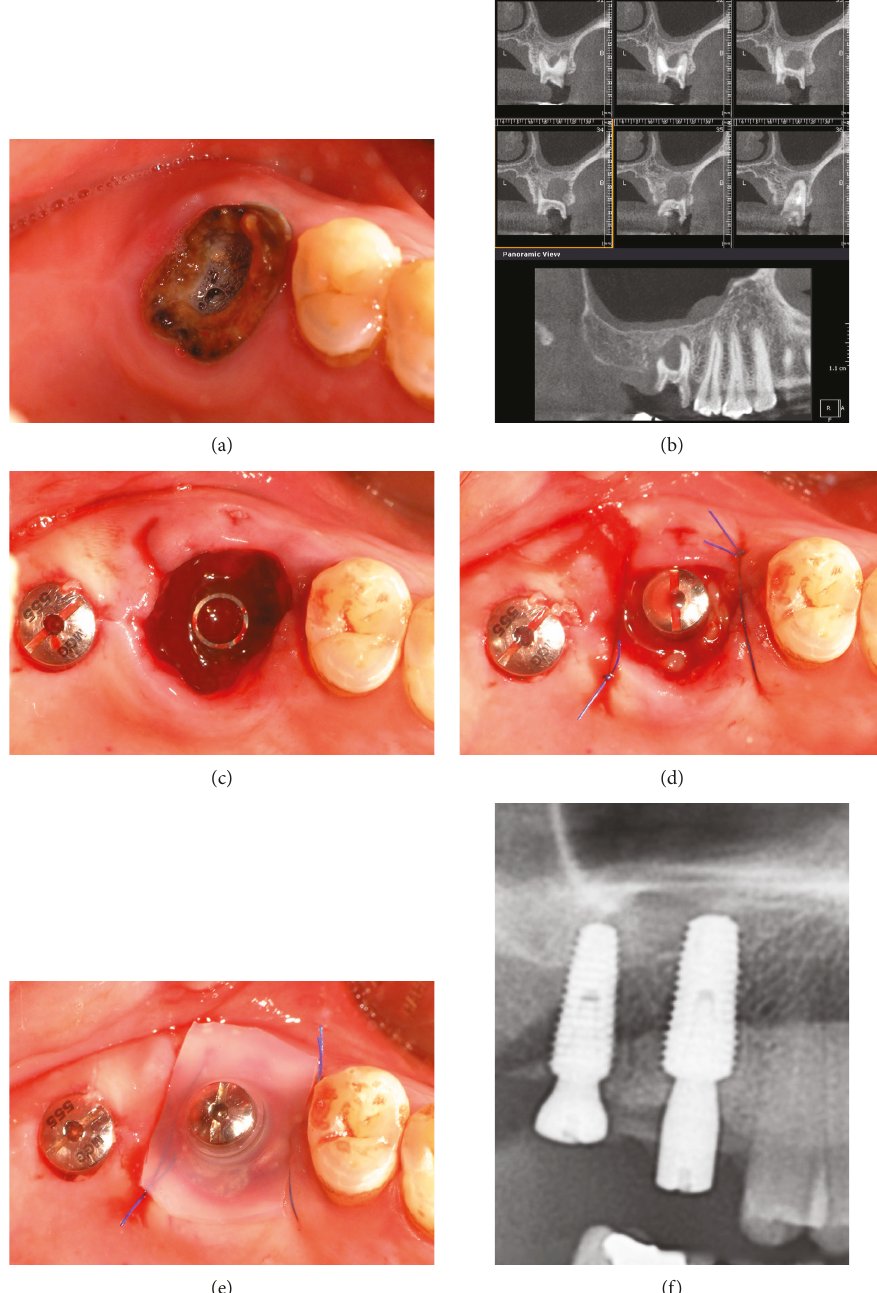
Figure 4: (a) Occlusal view at the initial examination. (b) Cone beam computerized tomography image at the initial examination. (c) Occlusal view immediately after the insertion of the implant. (d) Clinical condition of the interrupted sutures after gap fi lling of the extraction socket with allogenic bone and PRF. (e) Application of the silicone cap. (f) Radiograph taken immediately after implant